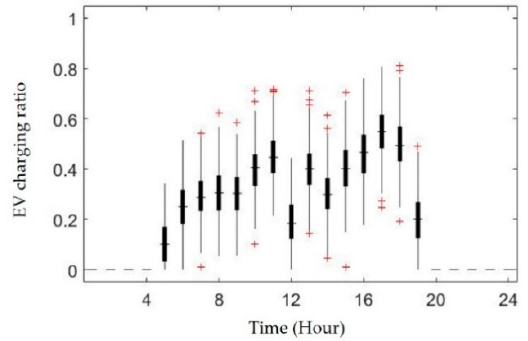
Figure 1. Statistical information on annual EV charging pattern for Case A.